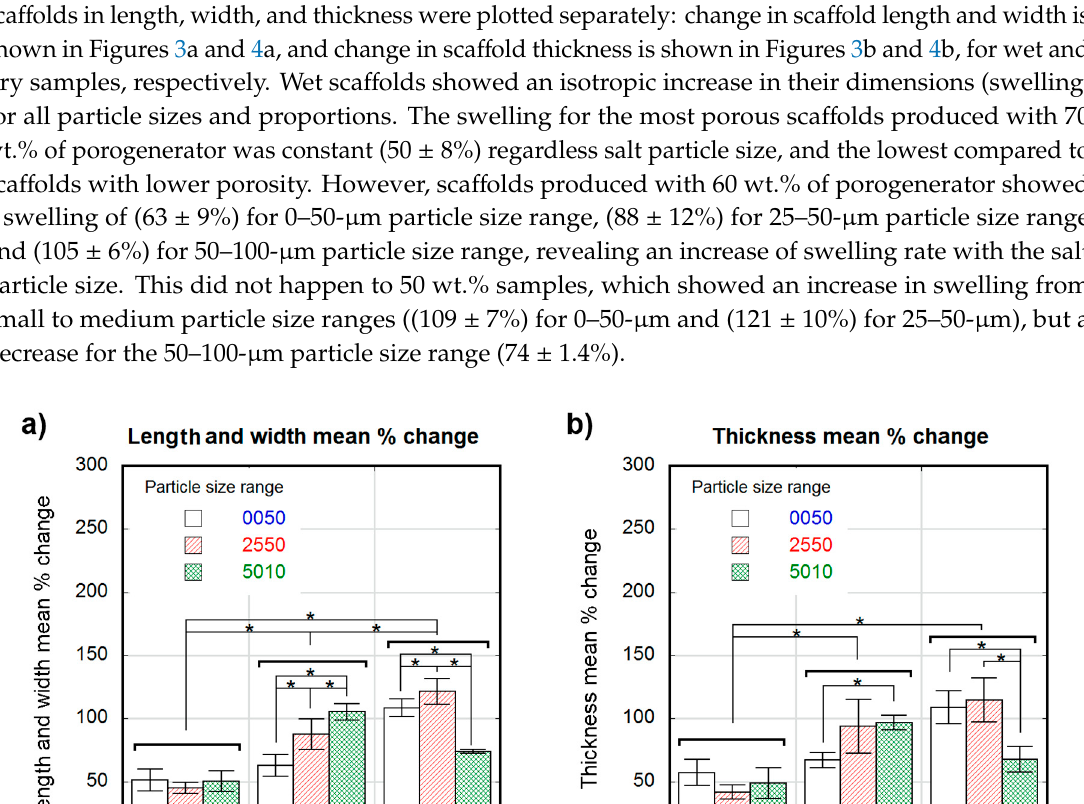
Figure 4 . Dimensional variation in percentagevalues for dry scaffolds obtained from different particle sizes (white 0–50-µm, stripe pattern 25–50-µm, cross pattern 50–100-µm) and proportions as a function of the theoretical percental amount of porogenerator: scaffold length and width mean % change ( a ); scaffold thickness mean % change ( b ). Significance level according to the Student t -test * p < 0.05.